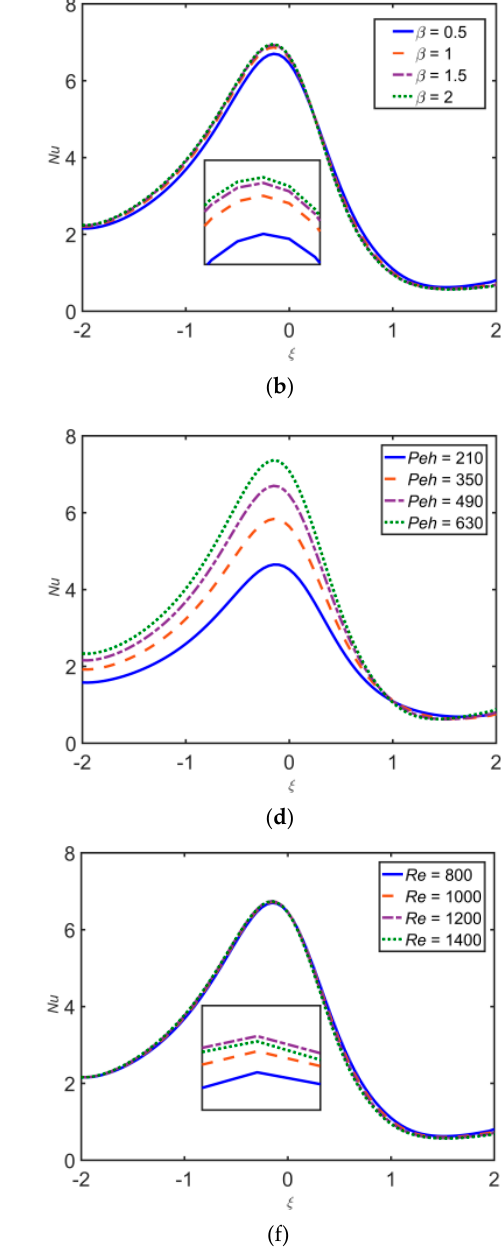
Figure 14 depicts the effect of various flow governing parameters on Nusselt number Nu . The Nu escalates as β , Re , and Peh estimations intensify. Nu reduces upon escalating M , D a , and Rd .